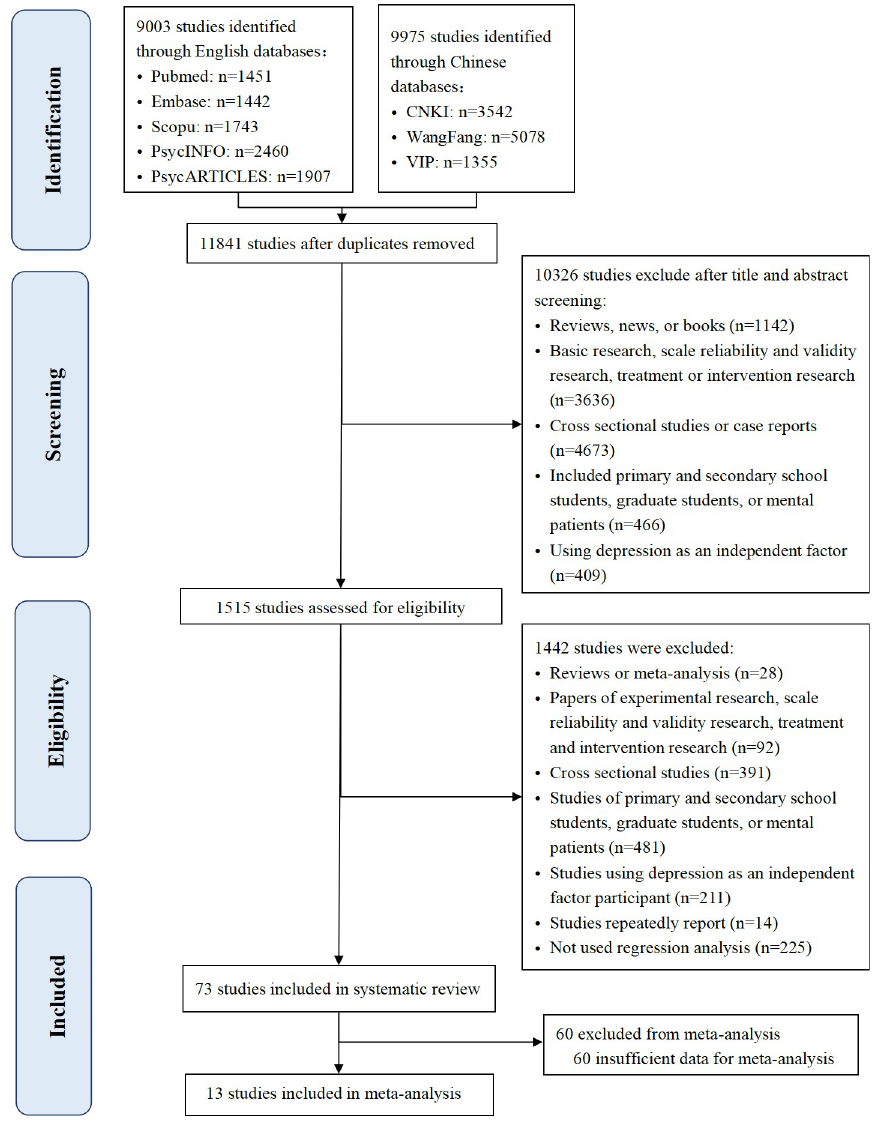
Fig 1. Flowchart of study